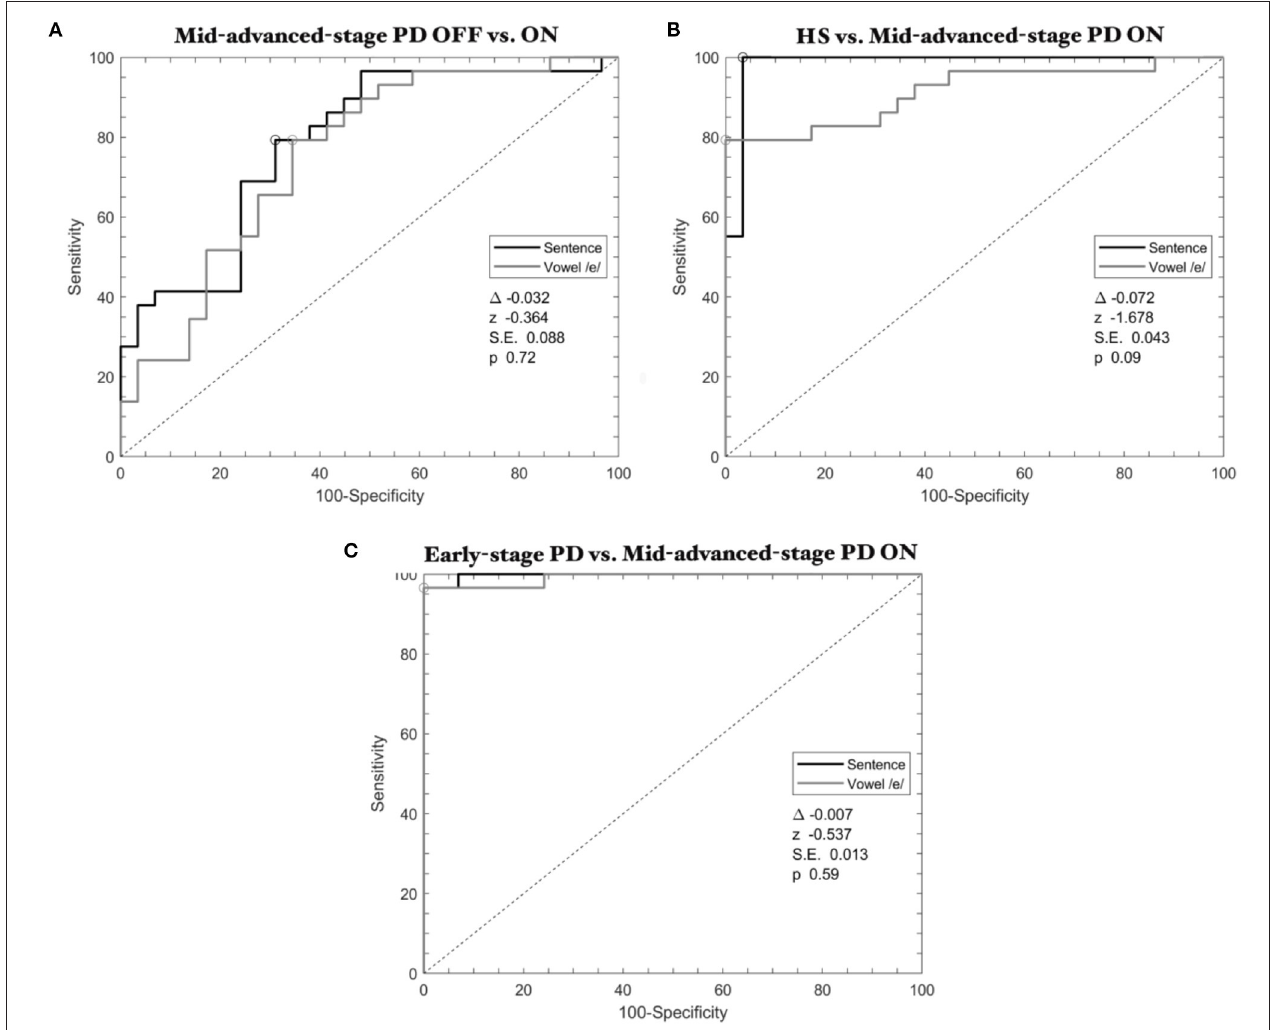
FIGURE 3 | ROC curves calculated through SVM classifier in Parkinson’s disease: the effect of L-Dopa. (A) Mid-advanced-stage patients OFF vs. ON therapy; (B) HS vs. mid-advanced-stage patients ON therapy; (C) Early-stage patients vs. mid-advanced-stage patients ON therapy. Gray lines refer to the emission of the vowel, whereas black lines refer to the